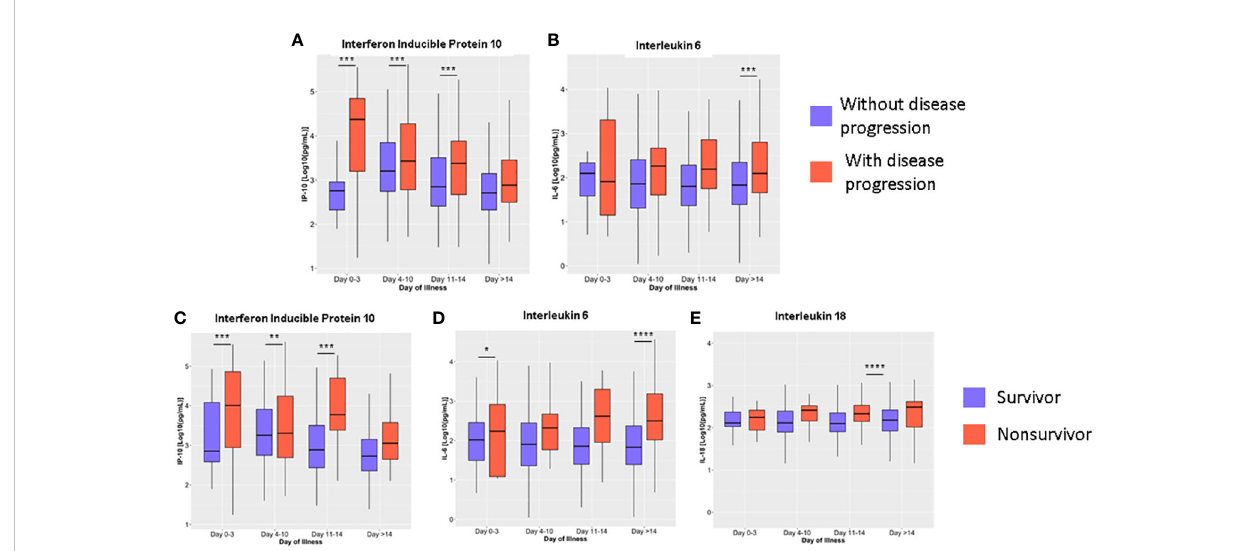
FIGURE 4 Dynamics of serum cytokine levels during the disease course in COVID-19 patients based on disease progression (A, B) and mortality (C – E) . The cytokines were measured in terms of days from illness onset. All samples collected from 400 patients were strati fi ed into four intervals starting from illness onset. The dots represent individual measurements, and the box plots represent medians with interquartile range. The different groups were compared by repeated measures mixed model regression with post hoc test. * p <0.05, ** p <0.01, *** p <0.001, **** p